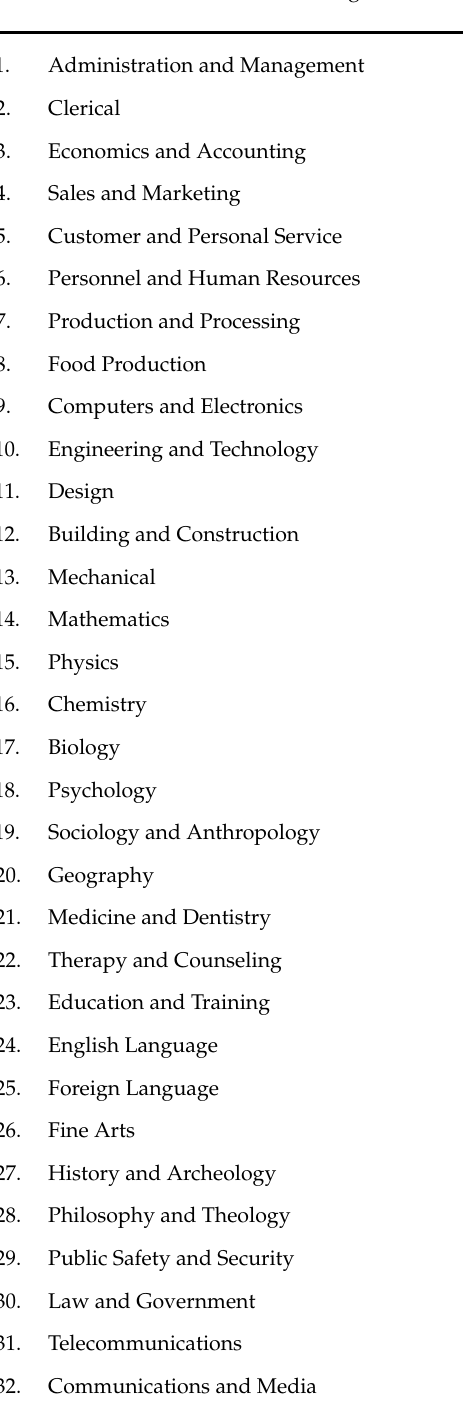
Table A1. O*NET Knowledge Questionnaire Items (numbered as in the